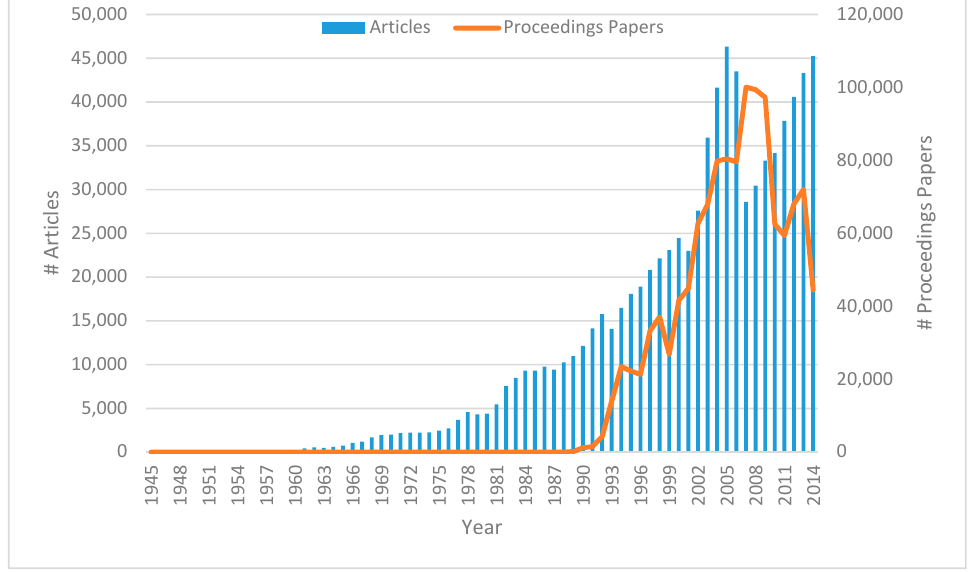
Figure 1. Number of articles ( Left ) and proceedings papers ( Right ) published in individual years.